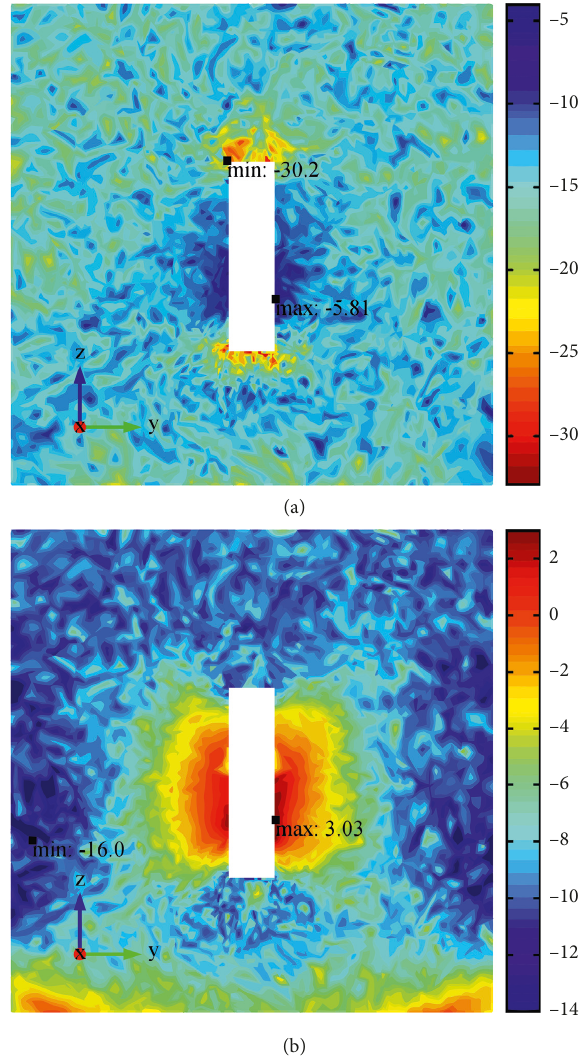
Figure 6: Distribution characteristics of principal stress (unit: MPa). (a) Maximum principal stress; (b) minimum principal